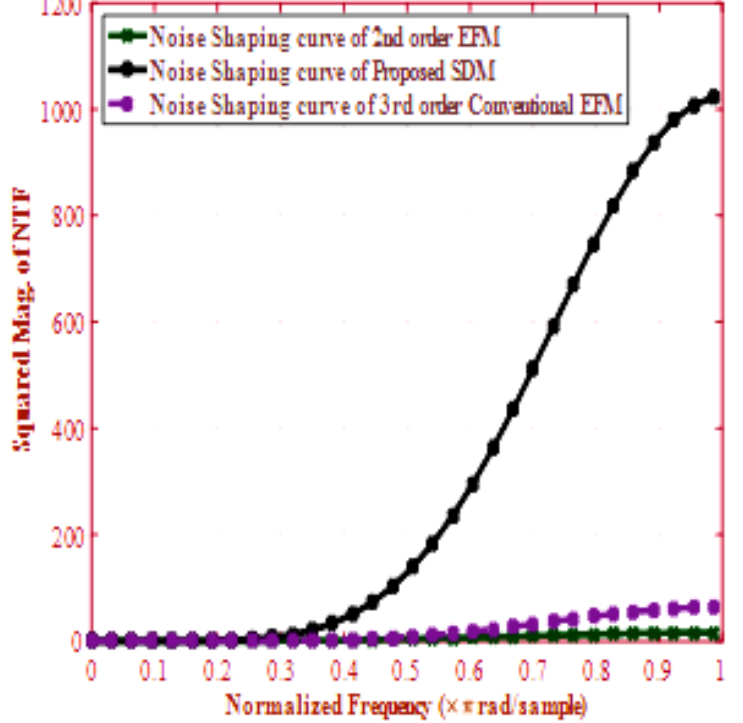
Figure 10. NTFs of 2nd order EFM, 3rd order EFM, and 3rd order hybrid MASH-EFM.